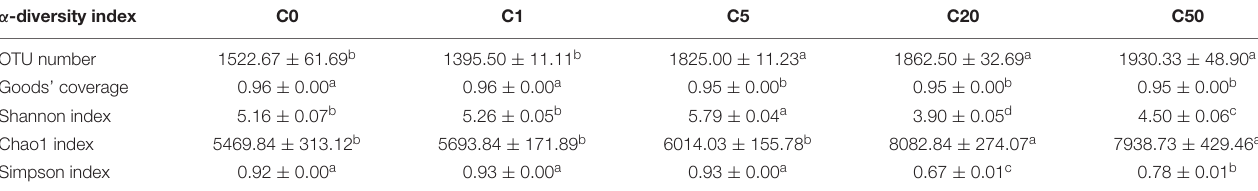
Different lowercase letters in the upper right corner indicate significant differences between